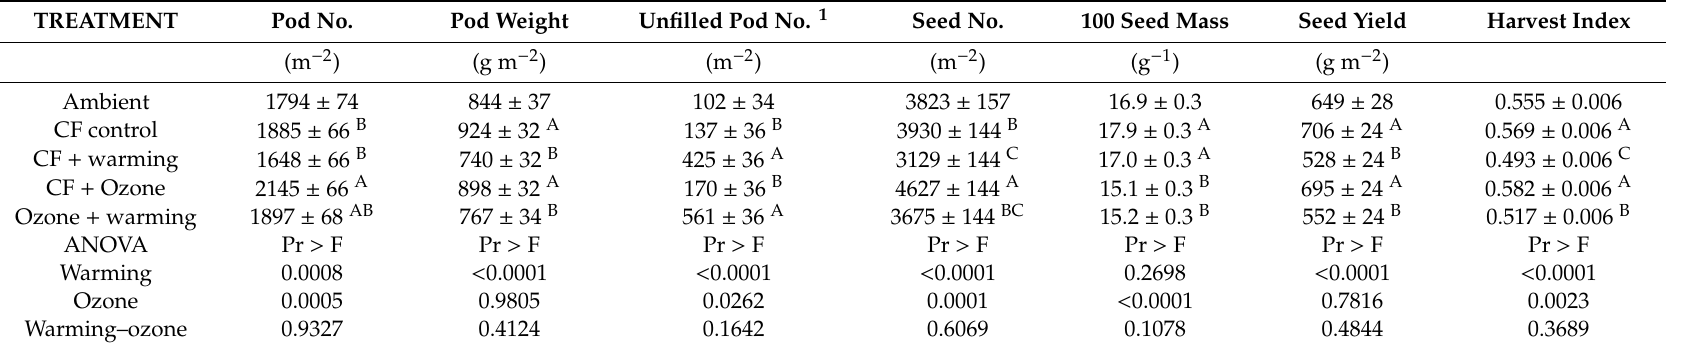
Table 4. Soybean final